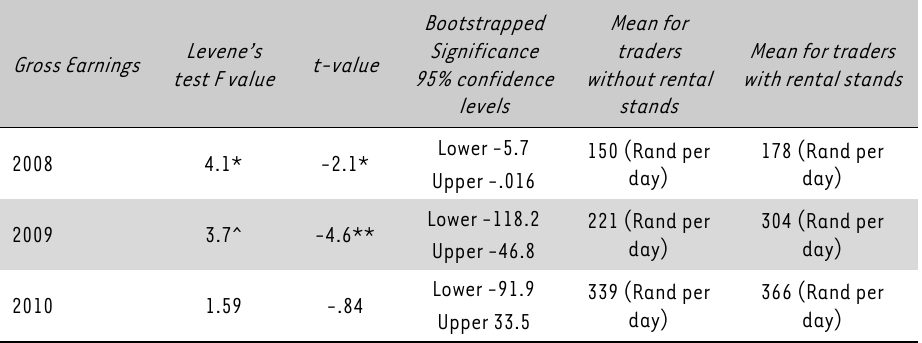
TABLE 6: Results of the t-tests for differences in Gross Earnings per day